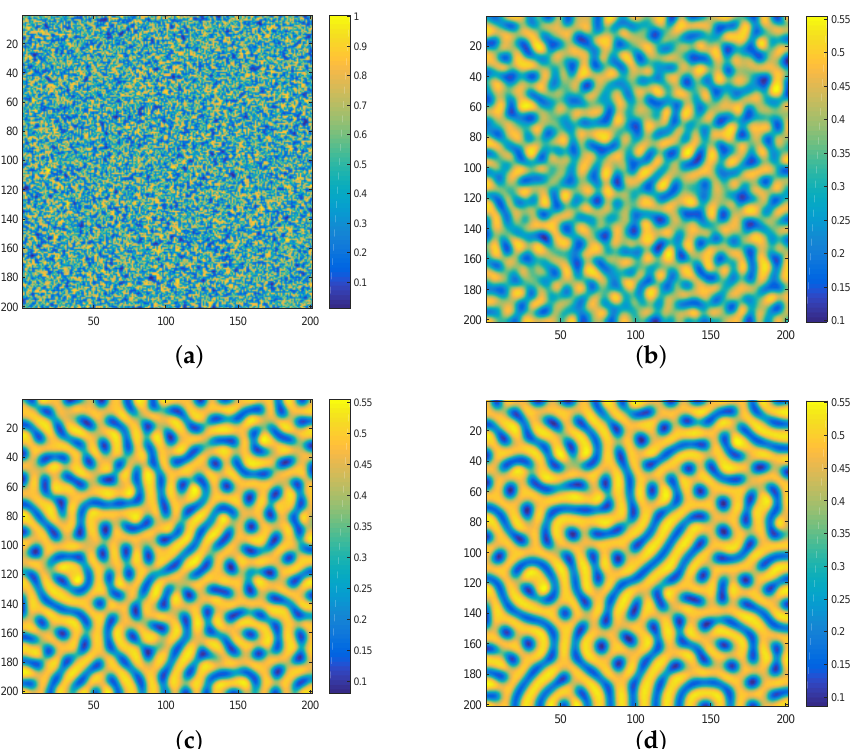
Figure 3. The patterns of u at c = 0.62, the other parameters are fixed as in (23). Times: ( a ) t = 0, ( b ) t = 50, ( c ) t = 200, and ( d ) t = 500.